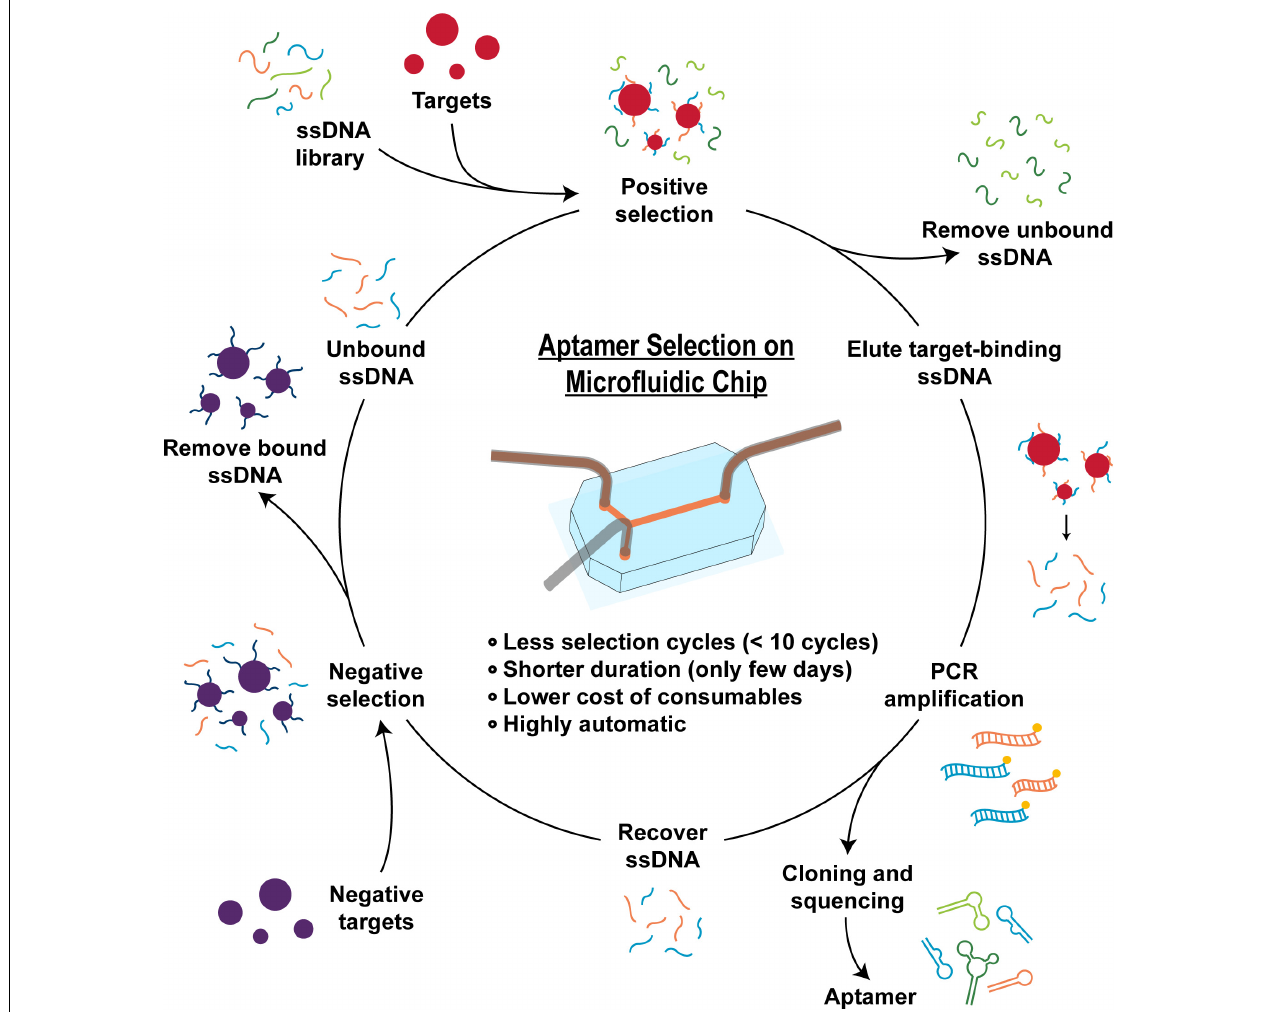
FIGURE 1 | Scheme of aptamer selection mechanism. The aptamer selection (SELEX) processes usually consist of four major steps: preparing a library of randomly generated oligonucleotide sequences, incubating with the target ligand, eluting bound sequences, amplifying the bound oligonucleotides by PCR, and obtaining ssDNA ready to undergo next SELEX cycle. Sometimes, negative selections are added to remove the non-specific binding sequences from the pool. With microfluidic-based SELEX, small amounts of fluids can be precisely manipulated inside the microfluidic devices, which can reduce the cost, improve the speed, increase the resolving power, and upgrade the extent of automation compared to the conventional SELEX